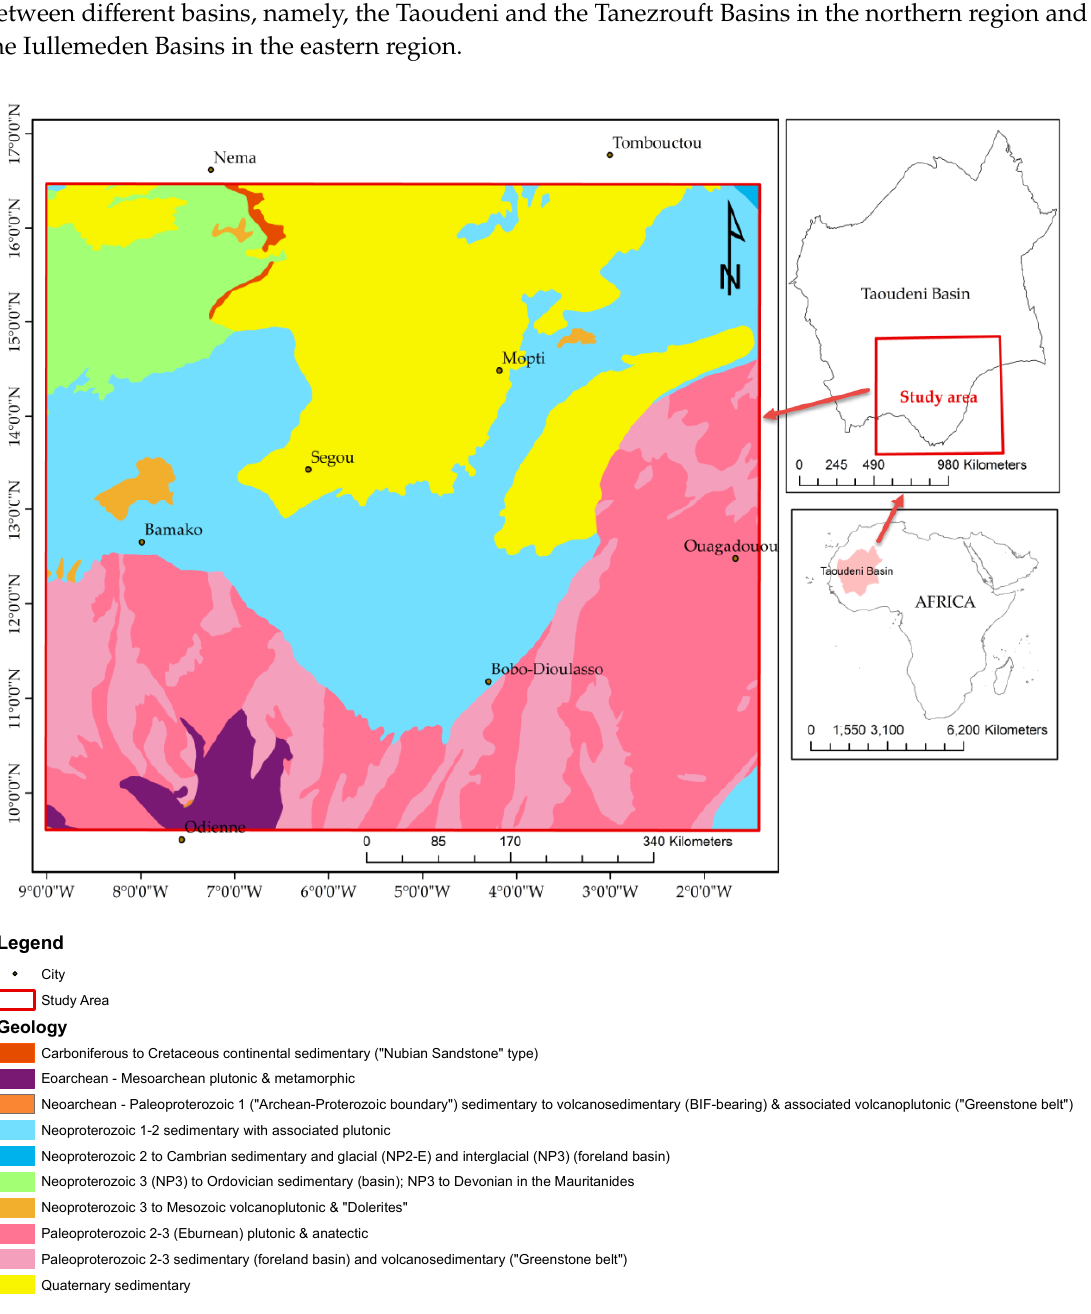
Figure 1. Geological map of the Taoudeni Basin’s southern edge.